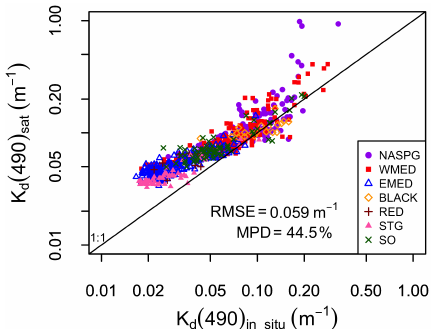
Figure 10. Log–log plot of the diffuse attenuation coefficient for PAR ( K d (PAR)) as a function of the diffuse attenuation coeffi- cient for downward irradiance at 490nm averaged within the first optical depth ( K d (490)). The dashed line is the fit to all data and corresponds to K d (PAR) = 0.062 ( ± 0.002) + 0.869 ( ± 0.011) K d (490) − 0.001 ( ± 4 × 10 − 5 ) K d (490) − 1 , with n = 3402. Dot- ted and solid lines represent relationships established by Morel et al. (2007a; Eqs. 9 and 9 (cid:48) , respectively) limited to the range of K d (490) found in that study. Biogeochemical-Argo data are grouped into seven major areas: Norwegian Sea, North Atlantic subpolar gyre and surrounding areas (NASPG); western Mediter- ranean Sea (WMED); eastern Mediterranean Sea (EMED); Black Sea (BLACK); Red Sea (RED); subtropical gyres and surrounding areas (STG); and Southern Ocean (SO).